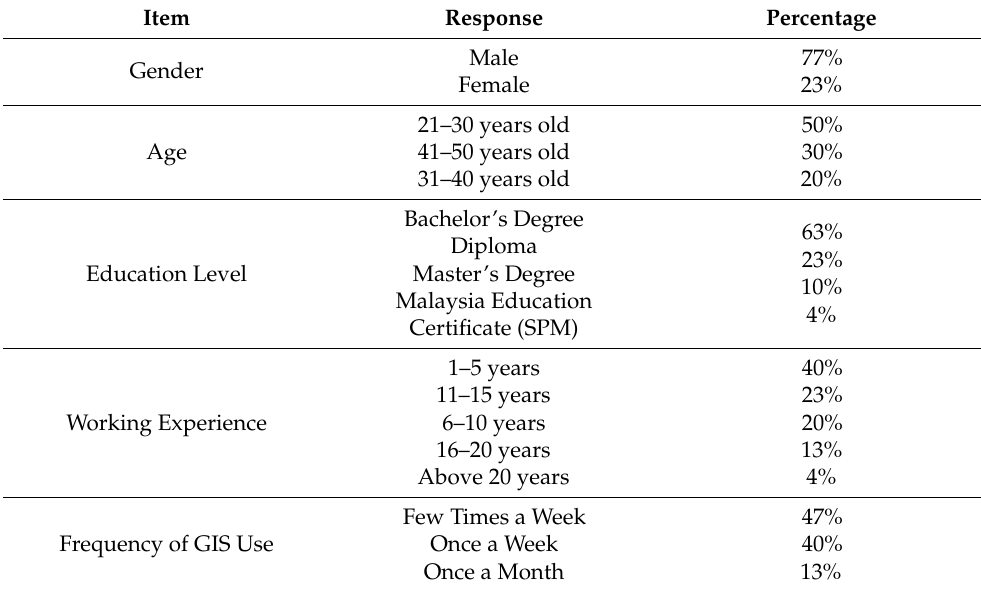
Table 3. Descriptive Statistic Demographic